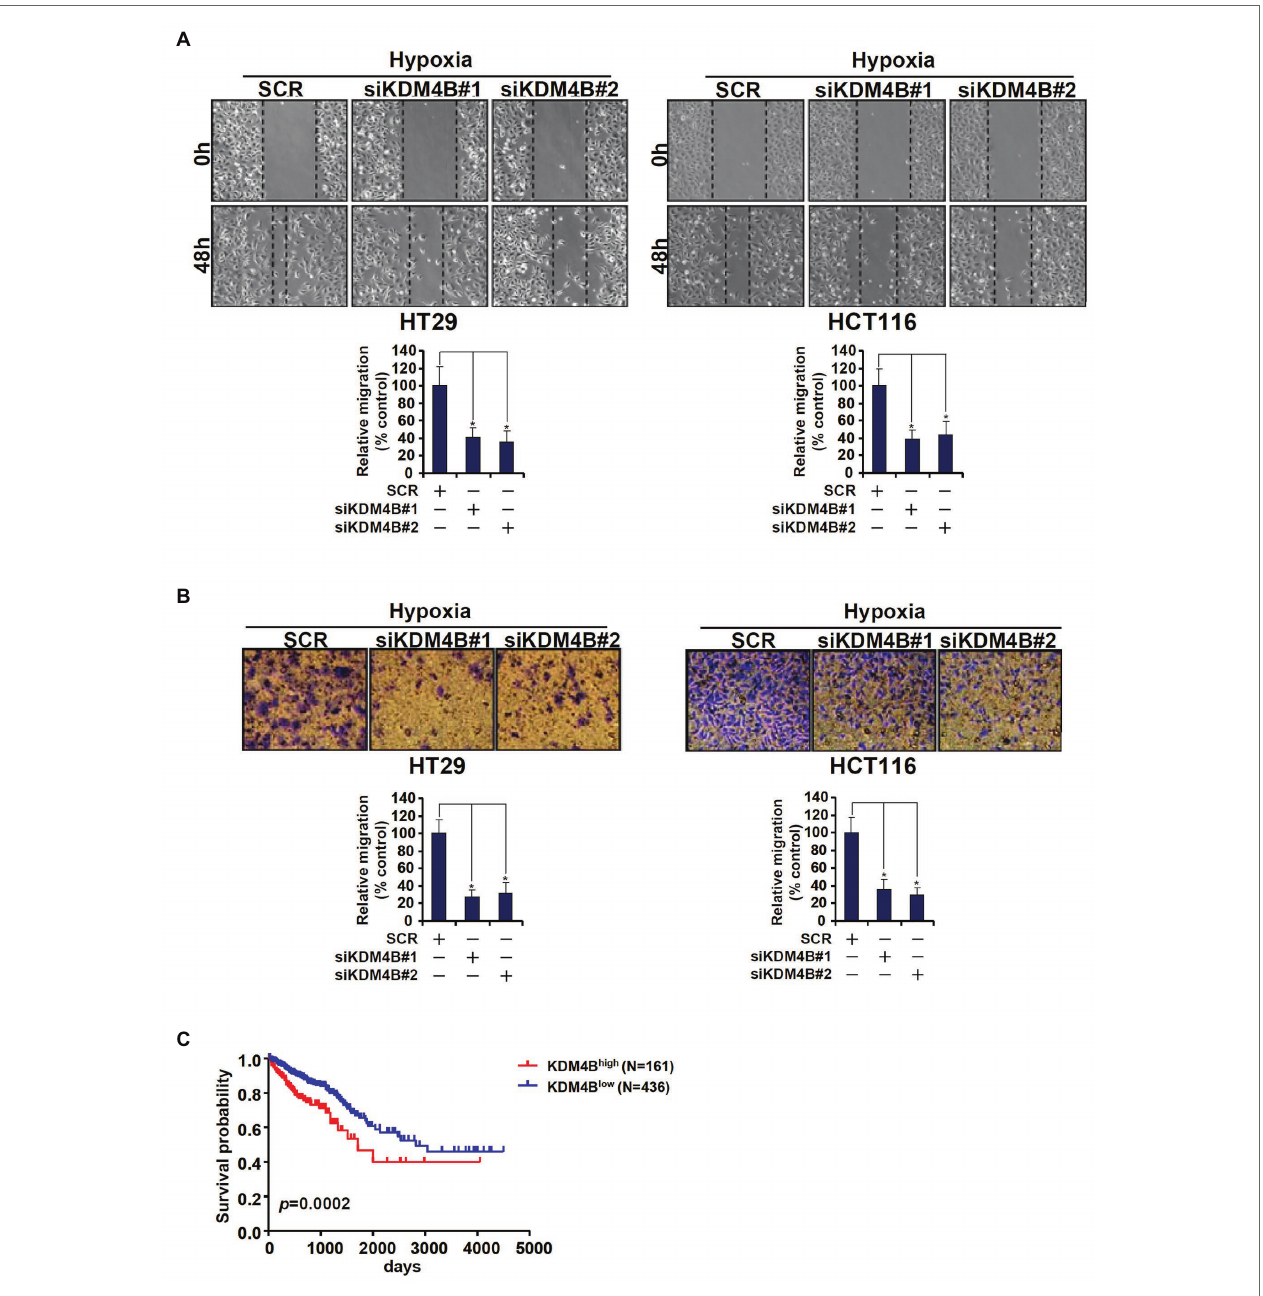
FIGURE 5 | KDM4B regulates CRC cell migration/invasion and is associated with poor prognosis in CRC patients. (A,B) HT29 and HCT116 cells were transfected with indicated siRNAs followed by exposure to hypoxia. Wound healing assay and trans-well assay were performed and quantified as described in the section “Materials and Methods.” (C) Kaplan-Meier plot of survival in CRC patients with high and low KDM4B